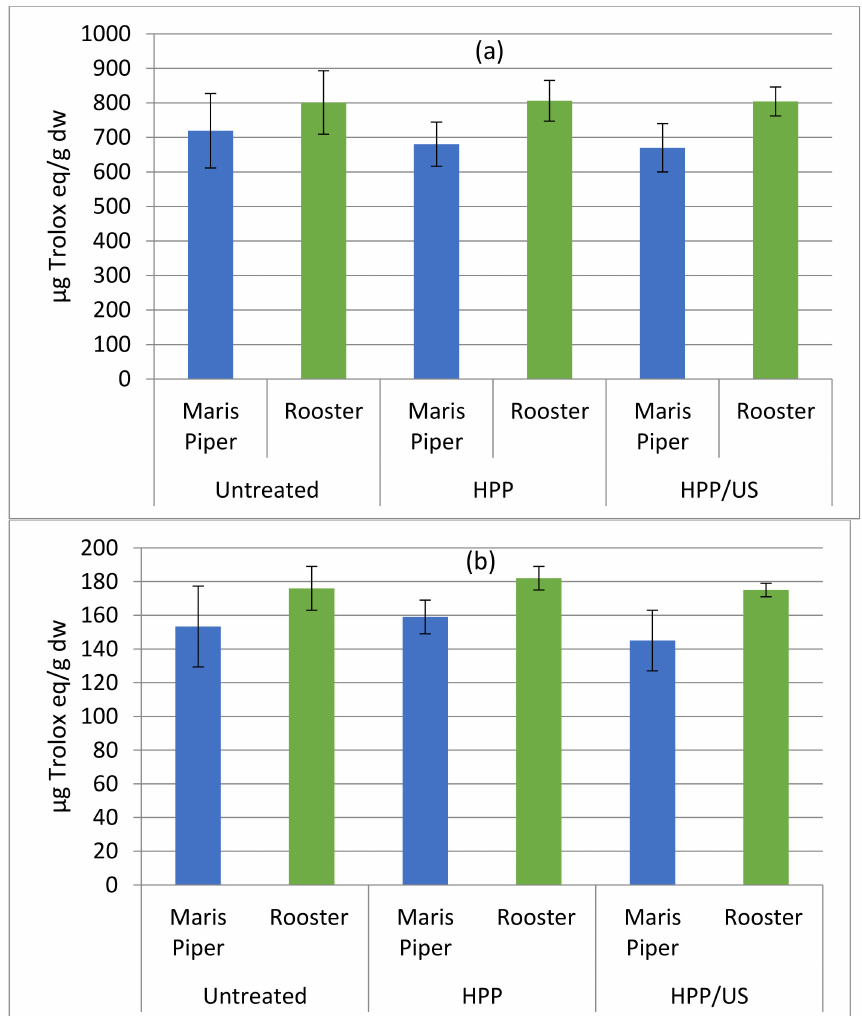
Figure 3. FRAP ( a ) and DPPH radical scavenging capacity ( b ) expressed as µ g Trolox equivalent (TE)/g dry weight in untreated, HPP- and HPP/US-treated minimally processed potatoes of the Maris Piper and Rooster